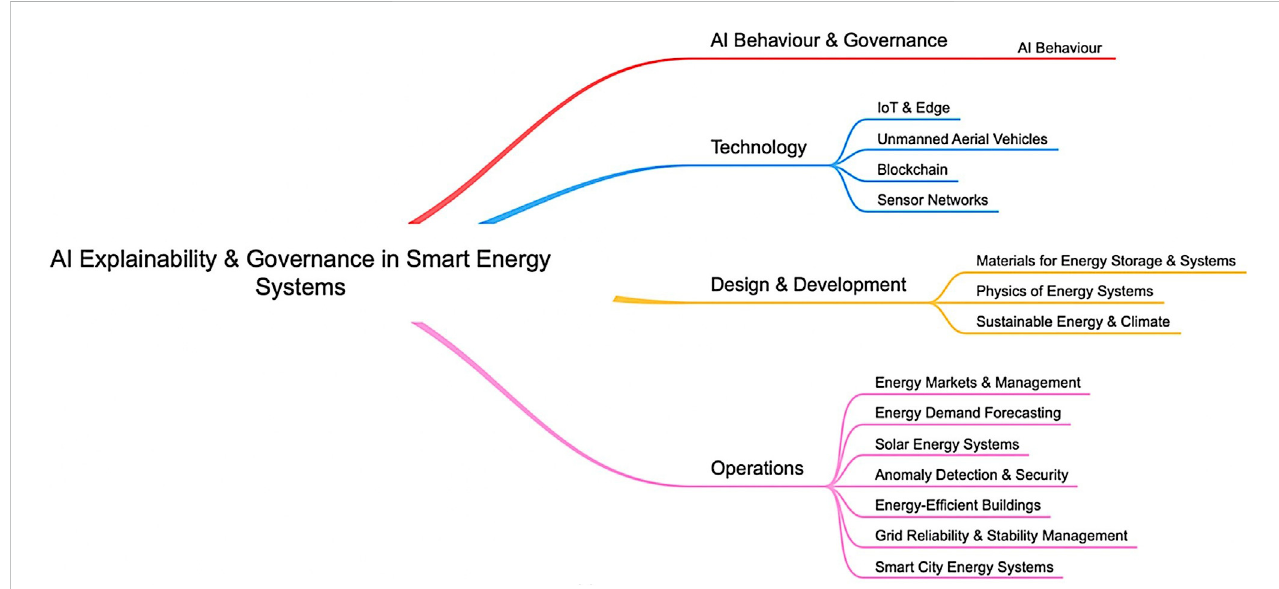
FIGURE 1 (A) taxonomy of parameters; temporal progression for: (B) ai behaviour and governance (C) technology (D) design and development (E)